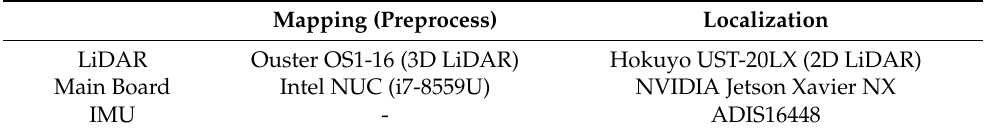
Table 3. The equipment used in the test.